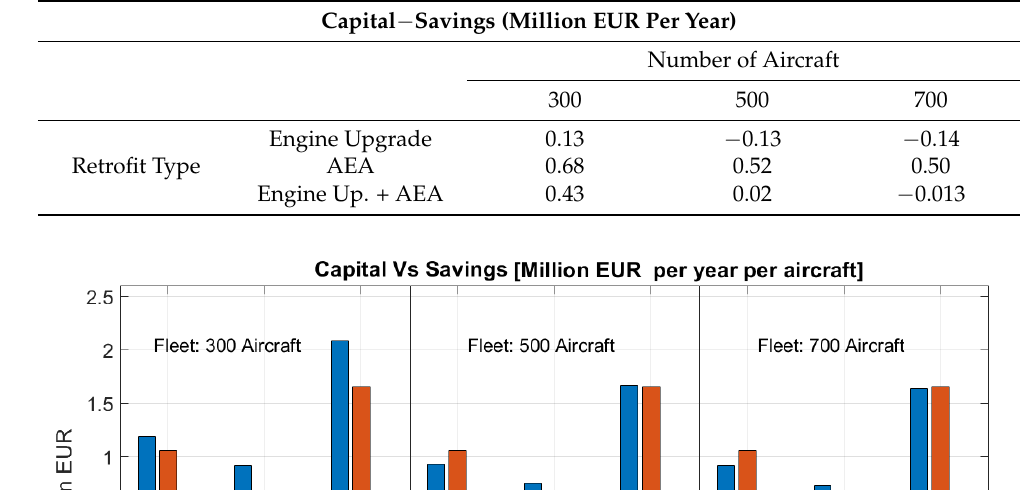
Table 15. Difference between capital costs and savings, related to three different retrofit solutions and three different fleet sizes.